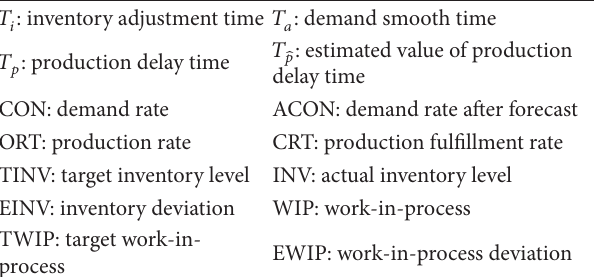
Table 1: Definitions of parameters and